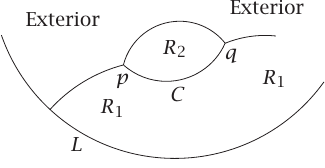
Figure 6.8 . C returns to the boundary of the exterior at the point q